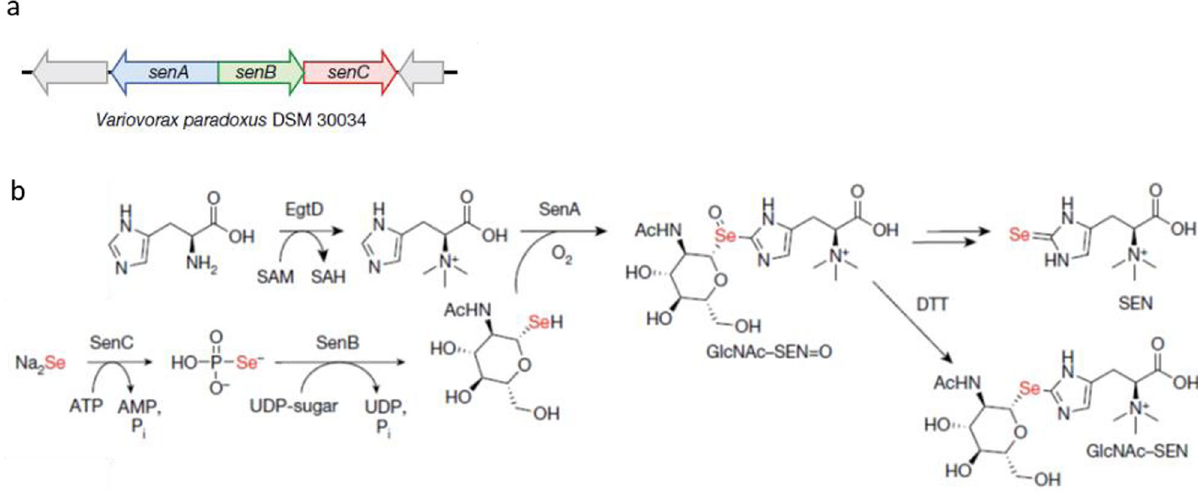
Fig. 1 Elucidation of a selenium incorporation pathway in microorganisms. a The sen gene cluster from the ß-proteobacterium V. paradoxus DSM 30034 and b the biosynthetic pathway of selenoneine (SEN). © The Author(s), under exclusive licence to Springer Nature Limited